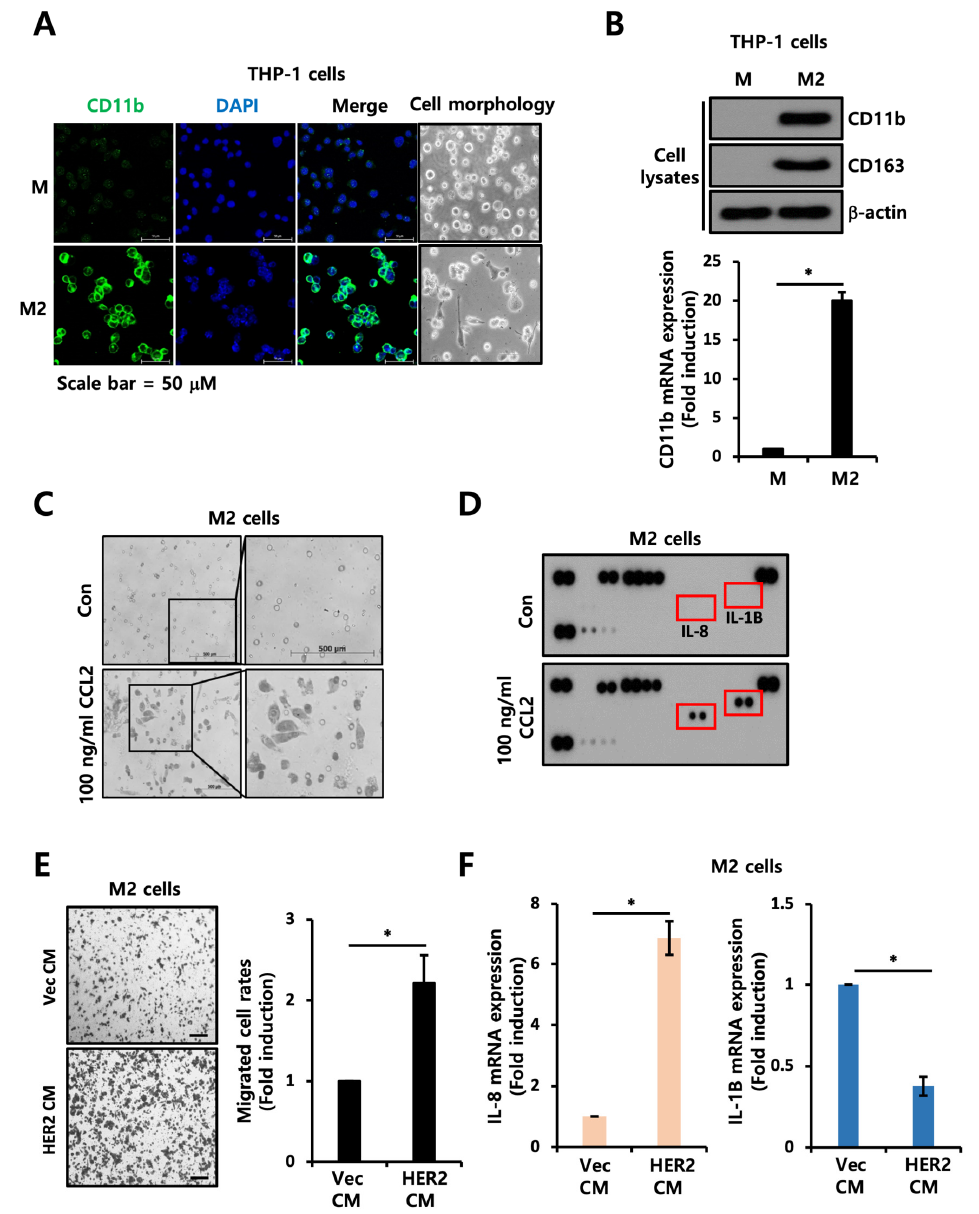
Figure 5. CCL2 mediates motility of TAMs. ( A ) Immunofluorescence confocal microscopy was performed using M0 and M2-differentiated THP-1 cells. Anti-CD11b primary antibody and Alexa Fluor 488-conjugated secondary antibody were used for staining. The nucleus was stained with DAPI. ( B ) Upper, levels of CD-11b and CD163 protein expression were analyzed using Western blotting with whole cell lysates from M0 and M2-differentiated THP-1 cells with indicated antibodies. β -actin was used as a loading control. Lower, transcript levels of CD11b in M0 and M2-differentiated THP-1 cells were analyzed using RT-qPCR. Values were normalized to ACTB. ( C ) Migration assays were performed as described in the method section. ( D ) Cytokine arrays were performed using whole cell lysates of control and CCL2-treated M2-differentiated THP-1 cells. ( E ) Migration assays were performed with M2-differentiated THP-1 cells treated with conditioned culture media from MDA-MB231 Vec and HER2-overexpressed cells. The scale bar represents 200 µ m. ( F ) RT-qPCR showing transcript levels of IL-8 and IL-1B in M2-differentiated THP-1 cells treated with conditioned culture media from MDA-MB231 Vec and HER2-overexpressed cells. Values were normalized to ACTB . * p <